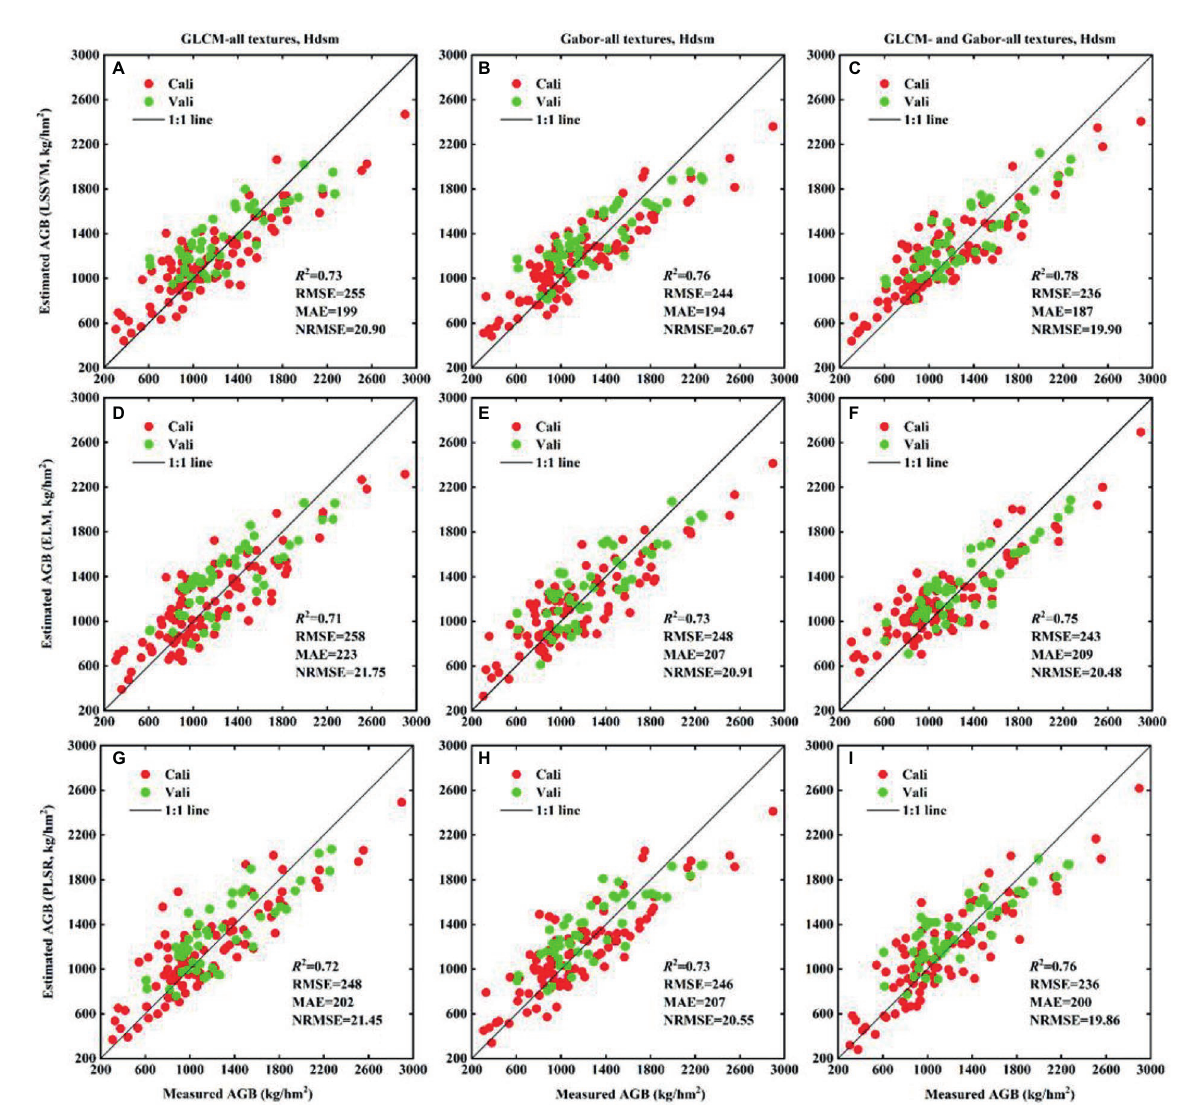
FIGURE 11 The fitted scatter plot of measuring and estimating potato AGB (kg/hm 2 ) using different ground resolution GLCM-based textures, different scales Gabor-based textures and crop height. (A–C) LSSVM; (D–F) ELM; (G–I) PLSR. GLCM-all textures, Hdsm represent combination of different ground resolution GLCM-based textures and crop height. The estimation results of Cali and Vali are shown in Supplementary Table